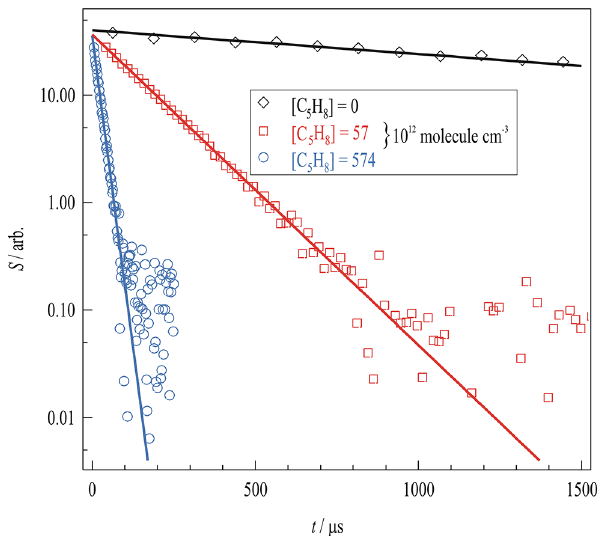
Figure 4. Time-resolved OH LIF signals, S , recorded in the pres- ence of different [isoprene] used to determine k 1 (298K). Pho- tolysis Reaction (R5) of [H 2 O 2 ] = 2 . 3 × 10 14 moleculecm − 3 was used to generate [OH] ≈ 5 × 10 11 moleculecm − 3 in P = 103Torr (N 2 ) . Unweighted fits with Eq. (2) yield first-order rate coefficients B for [isoprene] = 0 (black diamonds) B = ( 513 ± 12 ) s − 1 and [isoprene] = 57 × 10 12 moleculecm − 3 (red squares) B = ( 6654 ± 44 ) s − 1 ; [isoprene] = 574 × 10 12 moleculecm − 3 (blue circles) B = ( 53473 ± 700 ) s − 1